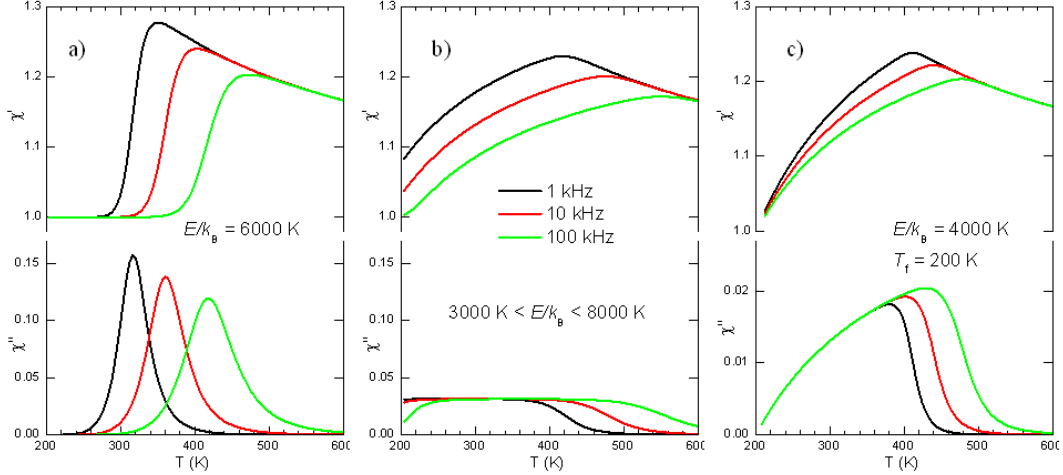
Figure 1. Real part and imaginary parts of the susceptibilities following Equation (15), with the three types of distributions of relaxation time: ( a ) single time with activation energy E / k B = 6000 K; ( b ) uniform distribution between 3000 K and 8000 K; ( c ) uniform distribution between τ 0 and Vogel-Fulcher